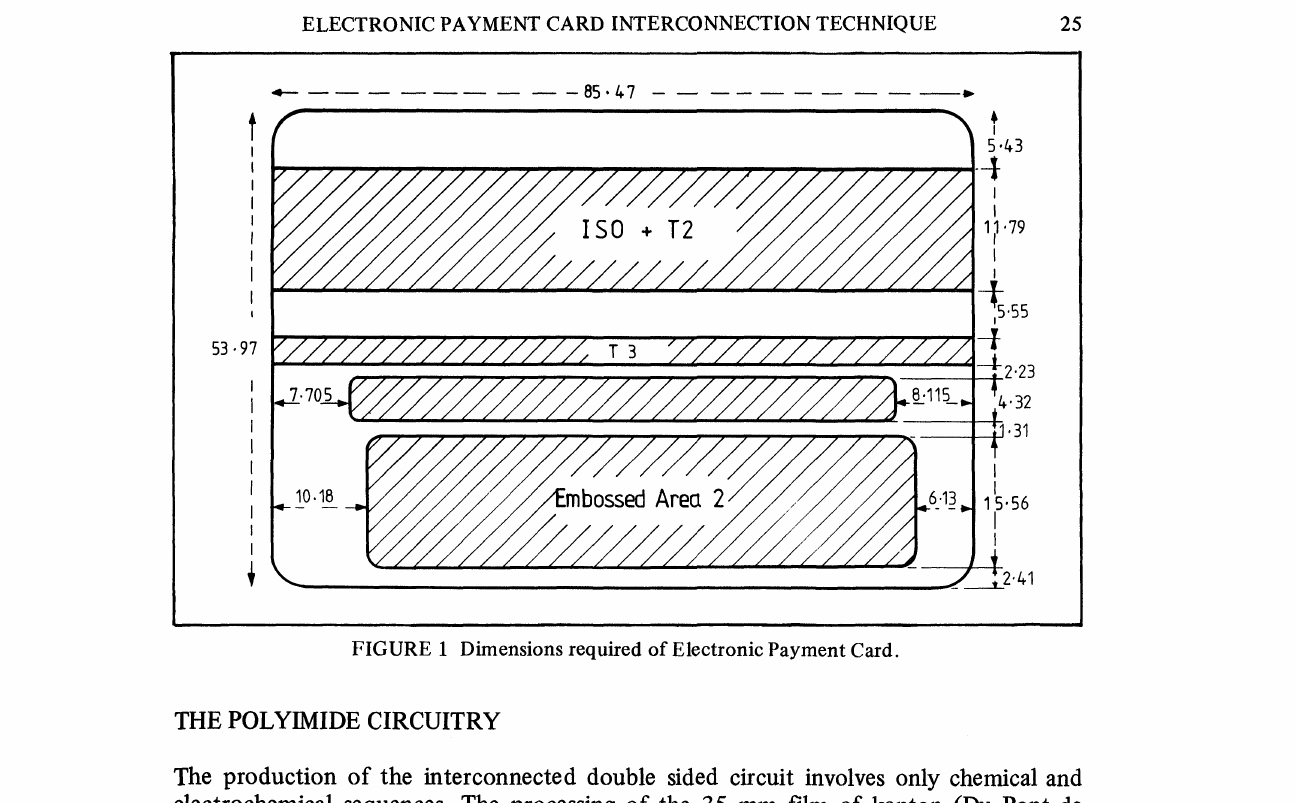
FIGURE Dimensions required of Electronic Payment